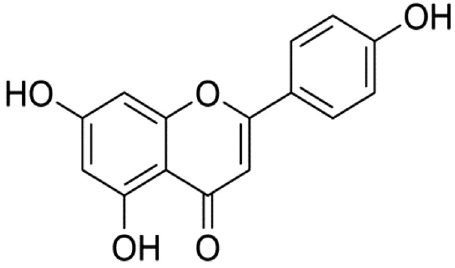
Fig. 6 Structure of apigenin (4 ′